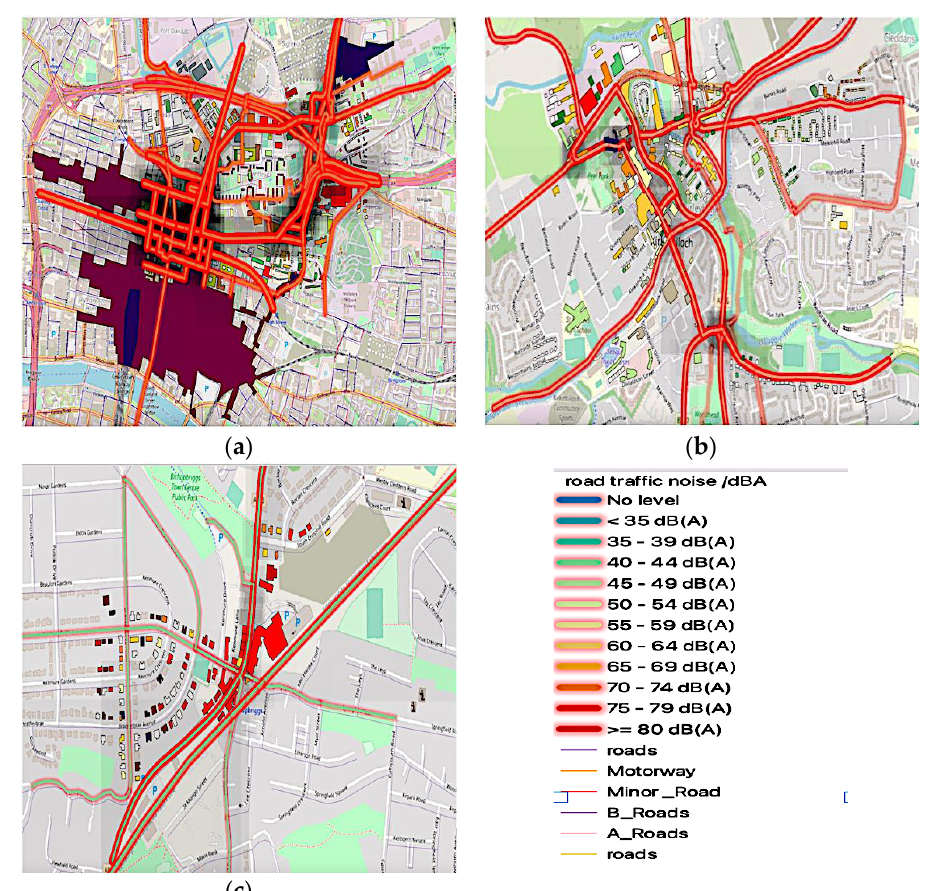
Figure 5. A model of road traffic annual average noise level (Lden) at monitoring areas at five monitoring locations (23 November 2021): ( a ) road traffic noise (Lden) at GHS, GK, and GT; ( b ) road traffic noise (Lden)at EDK; ( c ) road traffic noise (Lden) at EDB. Joint Annual Average of Air Pollutants ( µ g/m 3 ) and Noise Pollution at